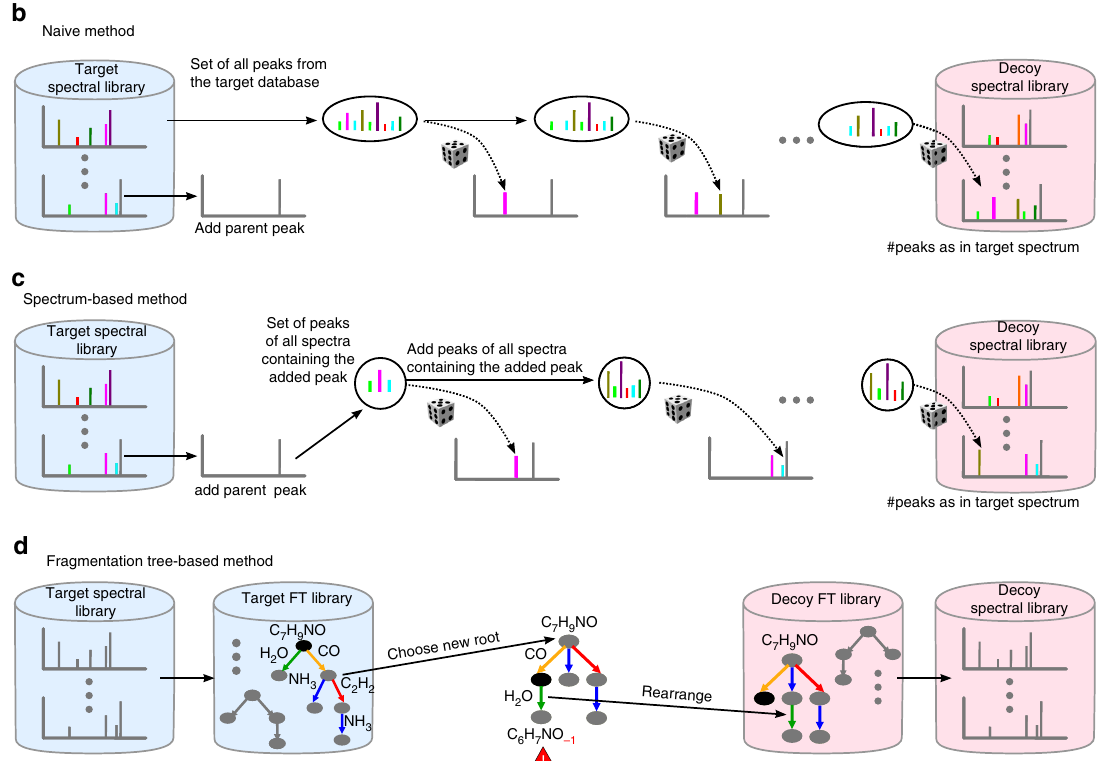
Fig. 1 False discovery rate estimation. a Overview. The empirical Bayes approach estimates FDRs from a two-component mixture of distributions representing true and false hits (positive identi fi cations). In the target-decoy approach, query spectra are searched against a target and decoy spectral library, and FDRs are estimated from the merged and sorted list of spectrum matches. b – d To construct a decoy spectral library, we implemented three methods. b Naive method: randomly adding fragment ions from the reference library to the decoy spectrum. c Spectrum-based method: fragment ions are iteratively added to the decoy spectrum, conditional on fragment ions that have previously been added. d Fragmentation tree-based method: a fragmentation tree is computed from the target spectrum, its root is relocated. New formulas of fragments are calculated according to the losses in the tree. Fragments with invalid formulas are